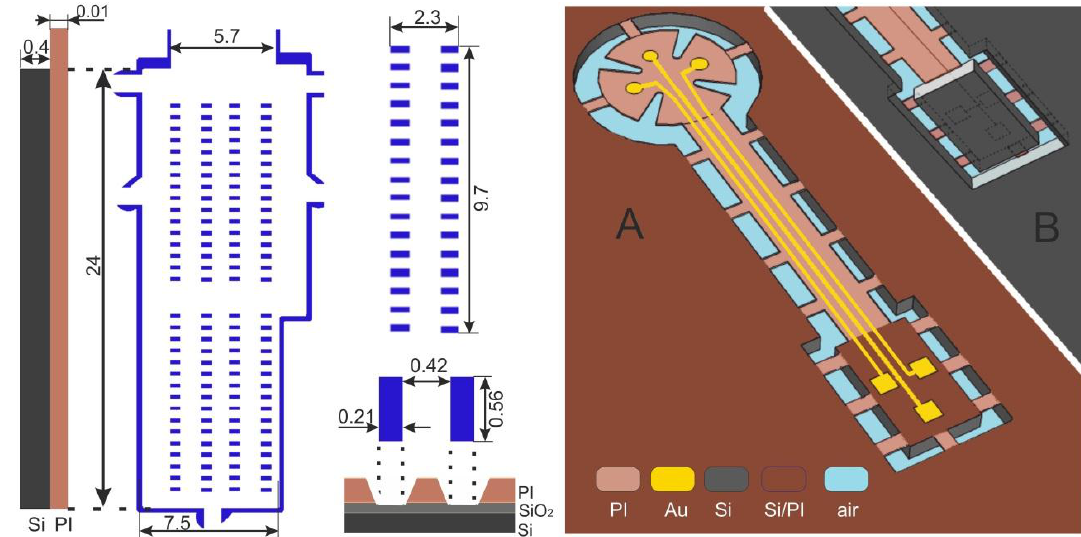
Figure 2. ( Left ) Connector-assembly region; ( Right ) A free-standing flex-rigid ECoG